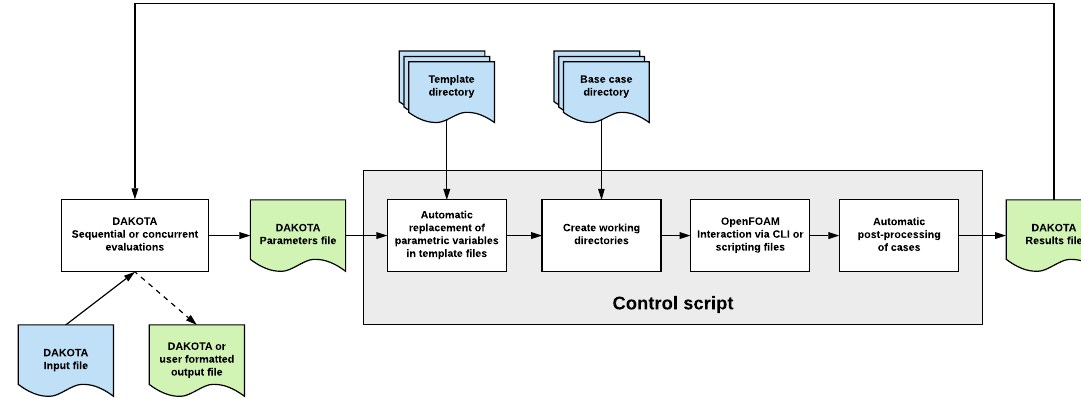
Figure 9. Workflow for data exchange between Dakota and OpenFOAM. The white rectangles denote process blocks, light-shaded blue document symbols denote unchanging sets of files, and light-shaded green document symbols indicate files that change with each set of design parameters generated by Dakota or after the end of the evaluation of the QoI. The light-shaded grey area denotes the domain of the control script that automatically prepares the case; this includes, CAD geometry, mesh generation, launching the solver, quantitative and qualitative post-processing, and automatic formatting of input and output